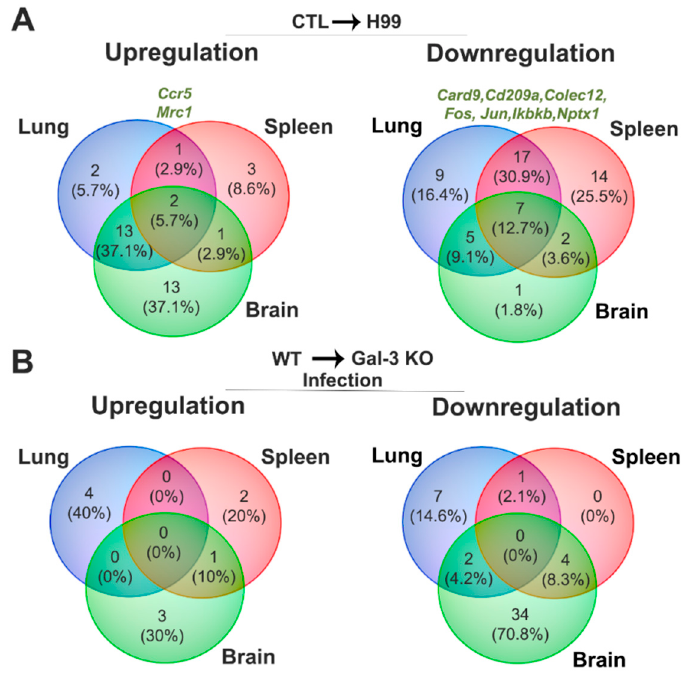
Figure 3. Expression levels of the genes involved in the mouse antifungal response in the absence of Gal-3 during cryptococcosis. Comparative Venn diagram of expressed genes up and downregulated in the lungs, spleen, and brain, during experimental cryptococcosis (H99) compared to the control group (CTL) in WT and Gal-3 KO animals (WT CTL vs. WT H99 and Gal-3 KO CTL vs. Gal-3 KO H99) ( A ) and absence of Gal-3 related to WT mice in C. neoformans infection (WT H99 vs. Gal-3 KO H99) ( B ). Venn diagram was designed using Venny